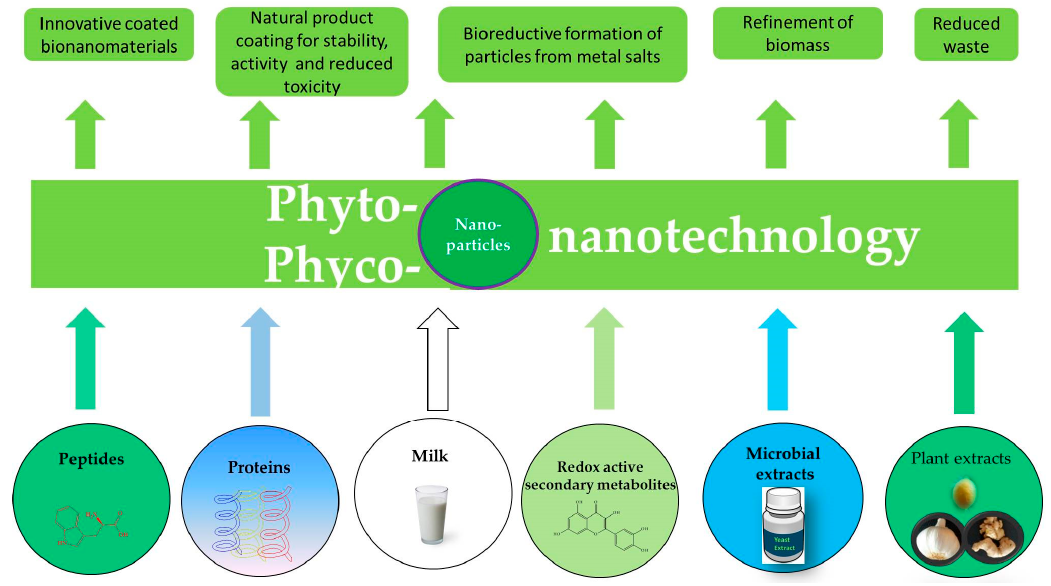
Figure 5. The emerging field of phyto-nanotechnology employs isolated biological components and substances to form, modify or coat nanoparticles. These particles often exhibit interesting properties, such as pronounced biological activity, and may therefore be employed in medicine or agriculture. Phyto-nanotechnology also offers new and innovative uses for plant materials and biomass, which otherwise may have been wasted. Here, the field of phyco-nanotechnology, which is centered around algae, for many biological, manufacturing, ecological and economical reasons today represents a particularly interesting area of research and development.